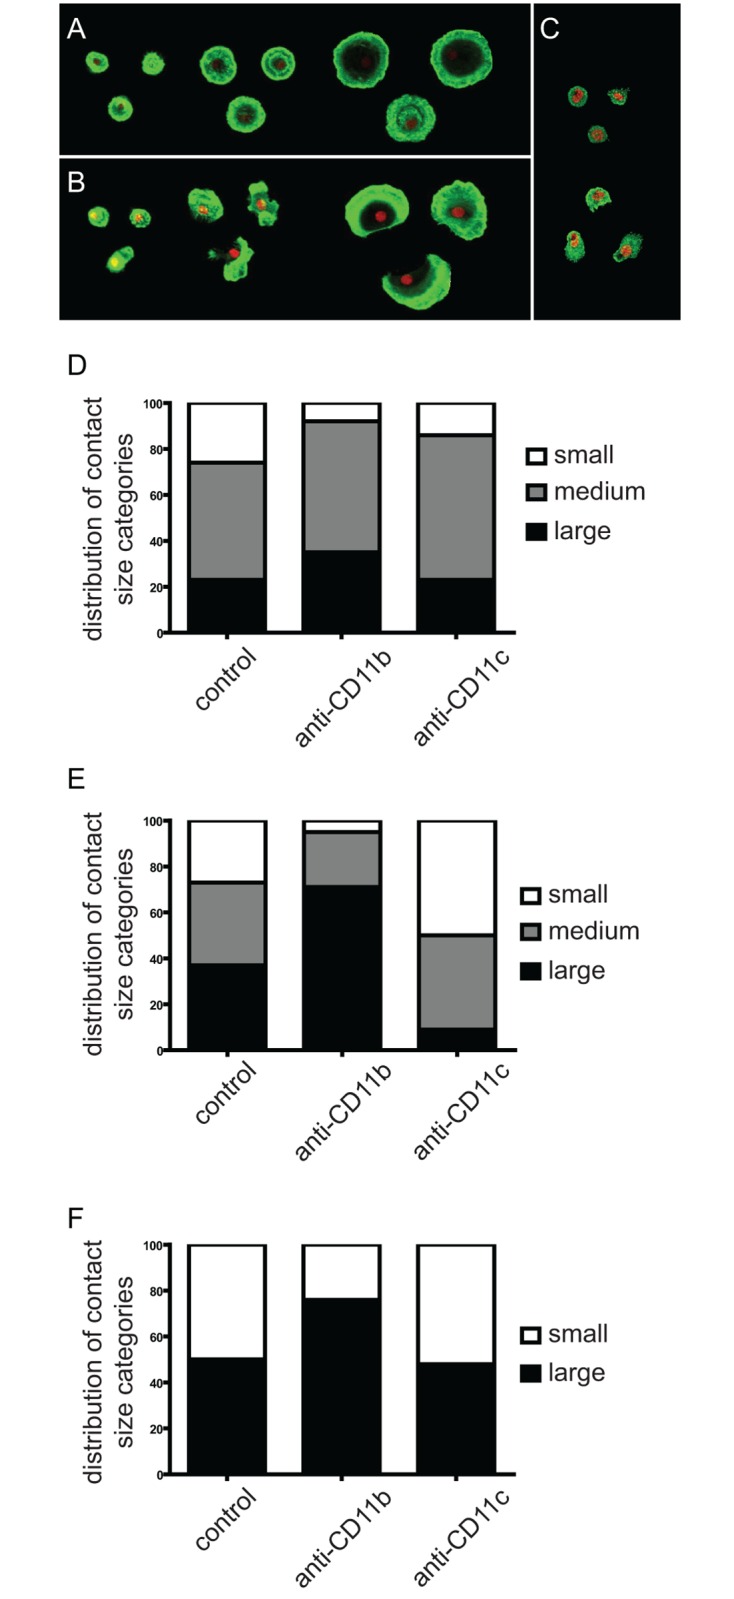
Contact zone size of cells after blocking CD11b or CD11c with antibodies.Cells were divided into categories based on the size of their contact zones. MDMs (A) and MDDCs (B) were categorised into the following three groups: small ≤2000 pixel2, medium 2000–400 pixel2, large ≥4000 pixel2. For monocytes (c) only 2 categories were established because of their smaller size (small ≤1000 pixel2, large> 100 pixel2). 200 cells were counted for each cell type and each treatment, and the distribution between the different contact size categories was determined and is shown for MDDCs (D), MDMs (E) and monocytes (F). Results of one representative experiment of three independent ones is shown.